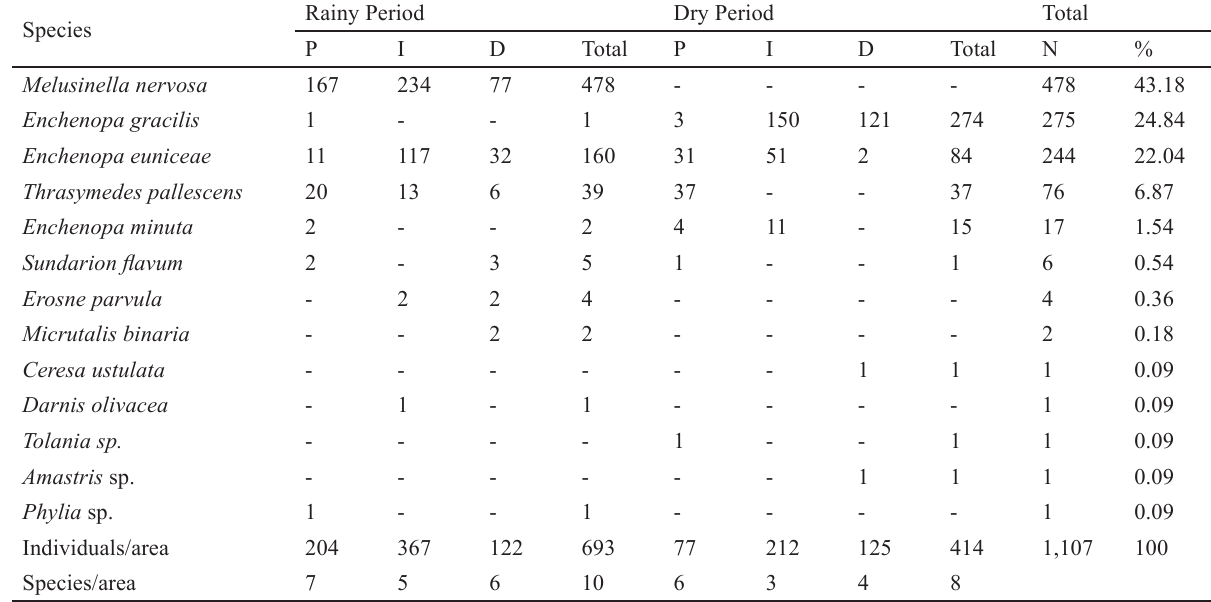
Table 1. Membracids collected in three areas with different vegetation structures in the Caatinga (P, preserved; I, intermediate; D, degraded) during the rainy and dry periods of 2006 in São José dos Cordeiros, Paraíba,